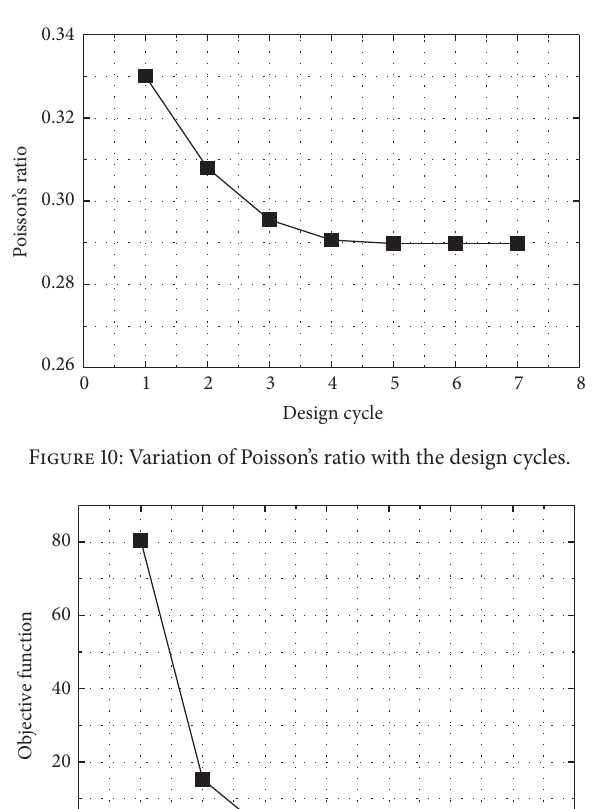
data exchange with the NASTRAN solver. The results of optimization are shown in Table 4 and Figures 13 and 14.